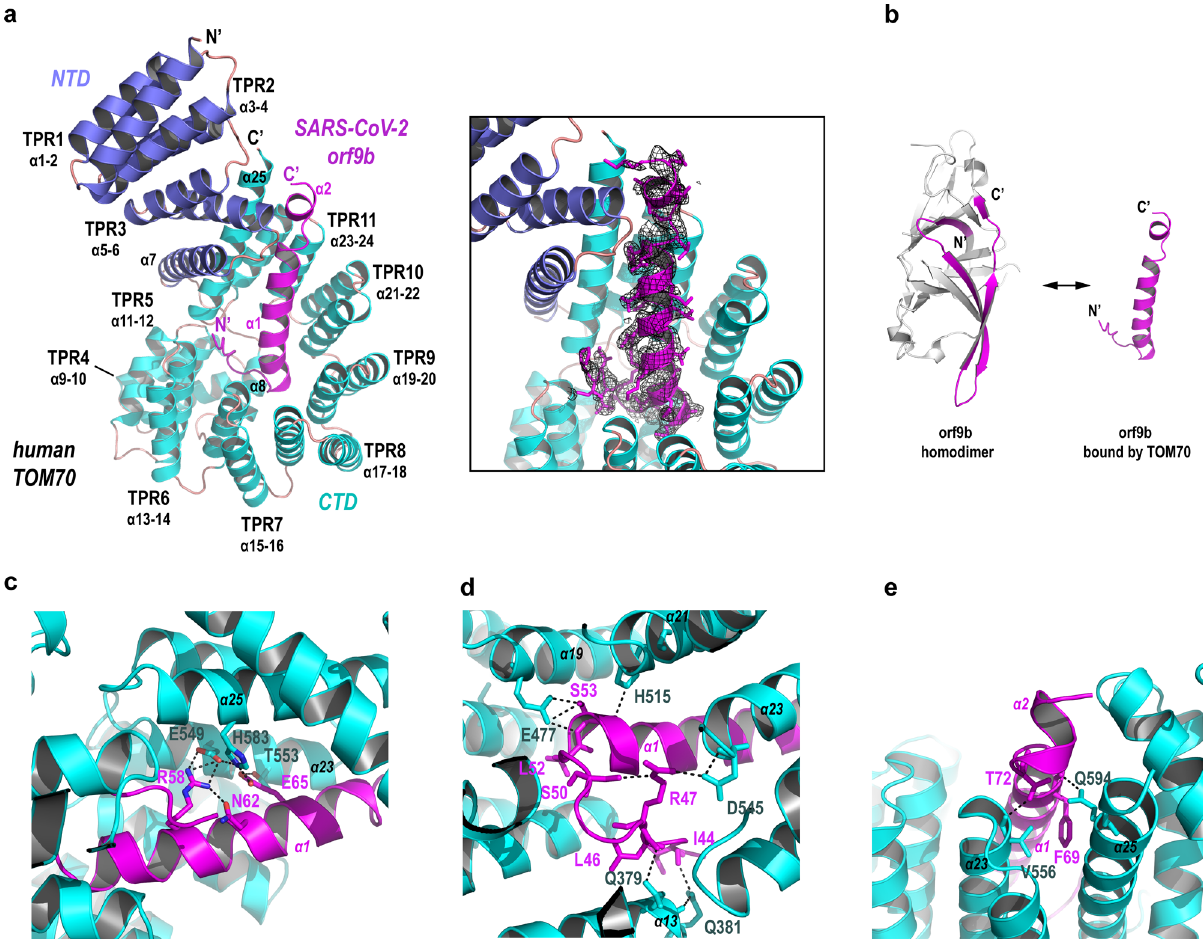
Fig. 2 Crystal structure of the hTOM70/SARS-CoV-2 orf9b complex. a Left, ribbon model of the hTOM70 cytosolic domain with SARS-CoV-2 orf9b occupying the CTD pocket. The NTD of hTOM70 is colored blue, the CTD is cyan and orf9b is magenta. Tetratricopeptide repeat (TPR) motifs and secondary structure elements are indicated. Right, magni fi ed view of SARS-CoV-2 orf9b inside the CTD pocket. The omit map (black mesh, calculated by program phenix.composite_omit_map) for orf9b is superimposed on the model. b Ribbon models of dimeric SARS-CoV-2 orf9b and the central portion of the same protein when bound to hTOM70. The segment of SARS-CoV-2 orf9b 43-78 adopts a β -strand rich structure in its dimeric form (right) and an α -helix rich structure in its bound form (left). c – e Details of polar interactions between SARS-CoV-2 orf9b and